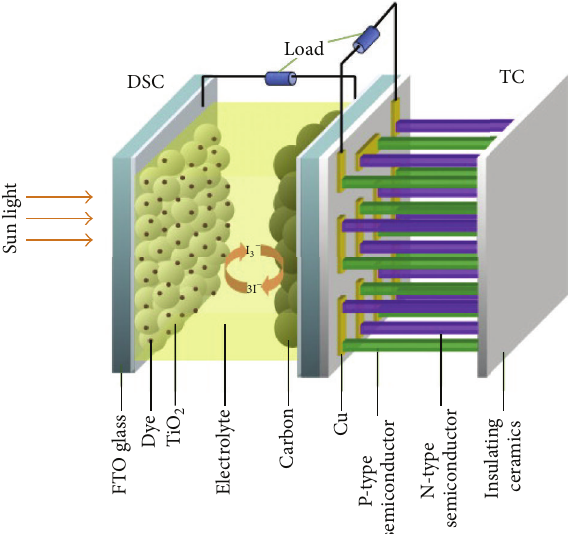
Figure 21: Schematic structure of TE generator-DSSC hybrid system